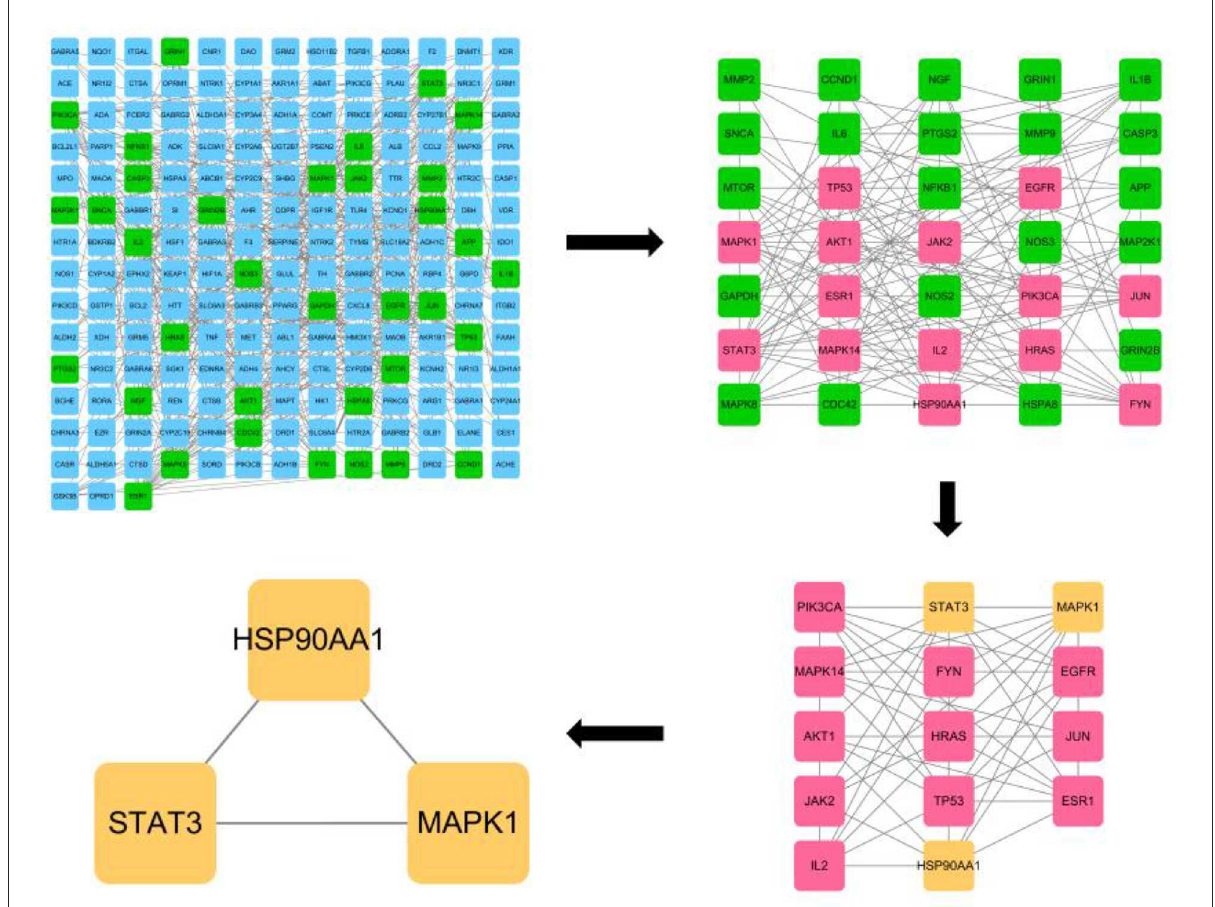
FIGURE2 CytoNCA plugin based core target screening of lotus root for its effect on acute alcohol